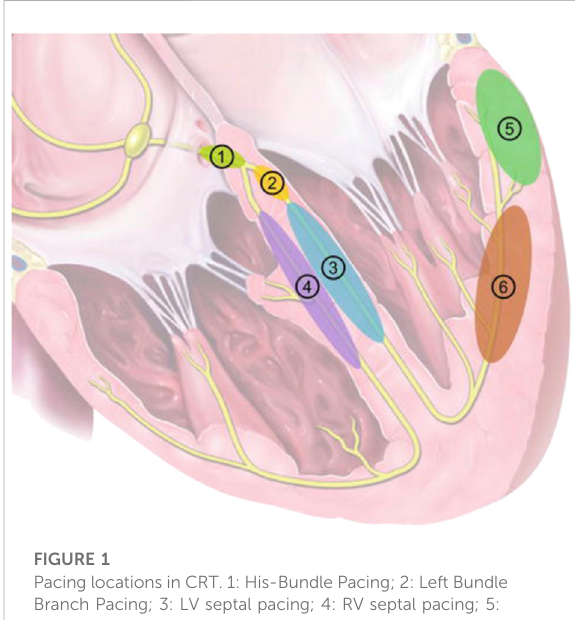
FIGURE 1 Pacing locations in CRT. 1: His-Bundle Pacing; 2: Left Bundle Branch Pacing; 3: LV septal pacing; 4: RV septal pacing; 5: Epicardial LV lateral wall pacing (conventional CRT); 6: LV endocardial pacing. Reproduced from reference 10, Karpenko et al., with